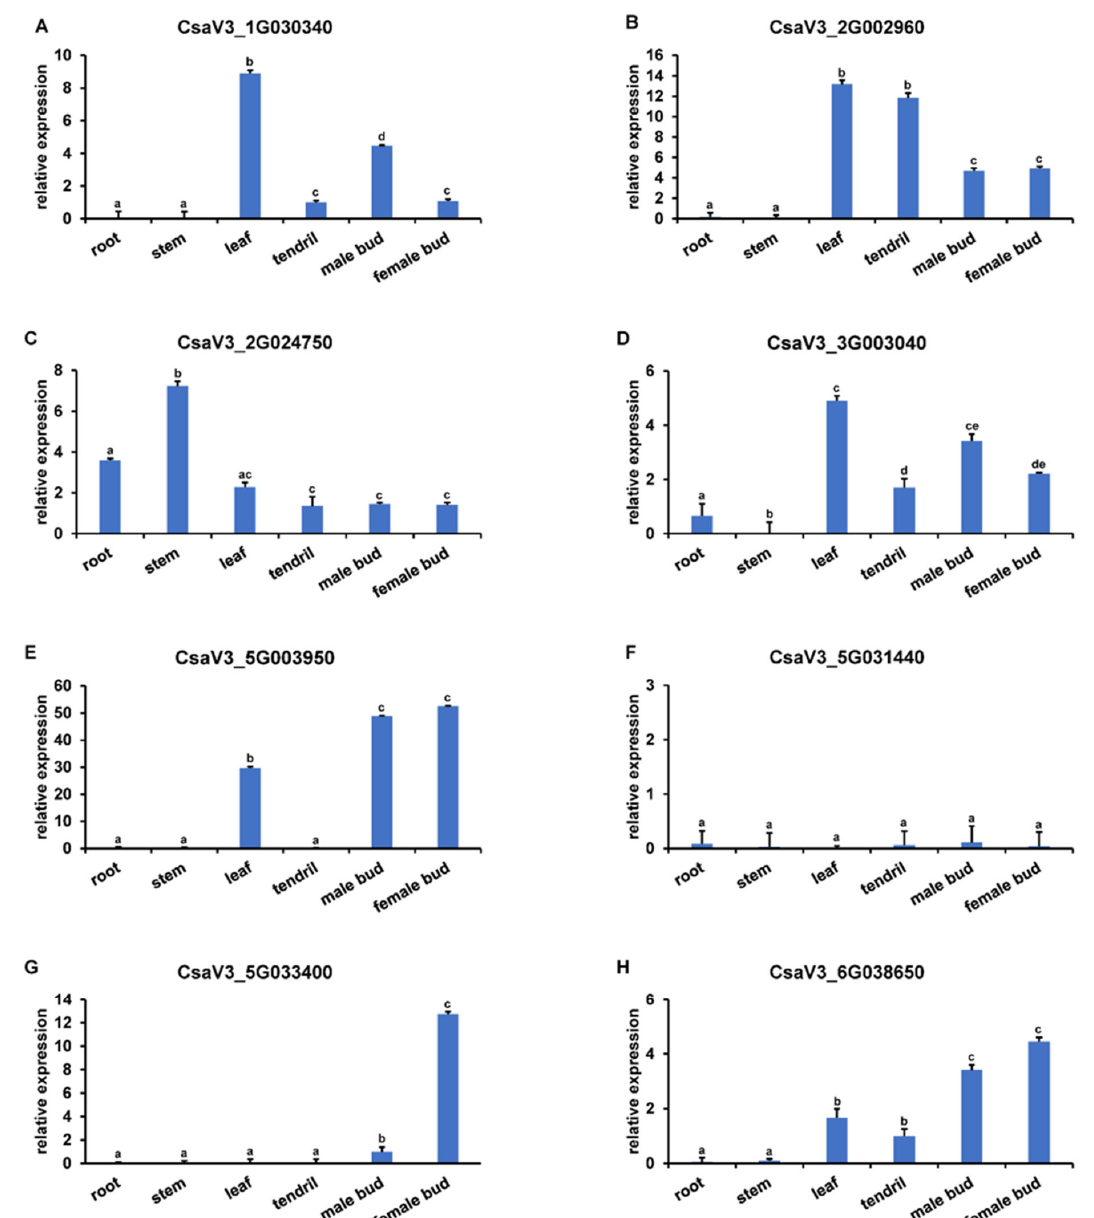
Figure 6. The expression patterns of CsYABBY genes in different tissues of cucumber. ( A – H ) Tissues-specific of CsYABBY expression was examined in cucumber by qRT-PCR. Values are means ± SD of three biological replicates.